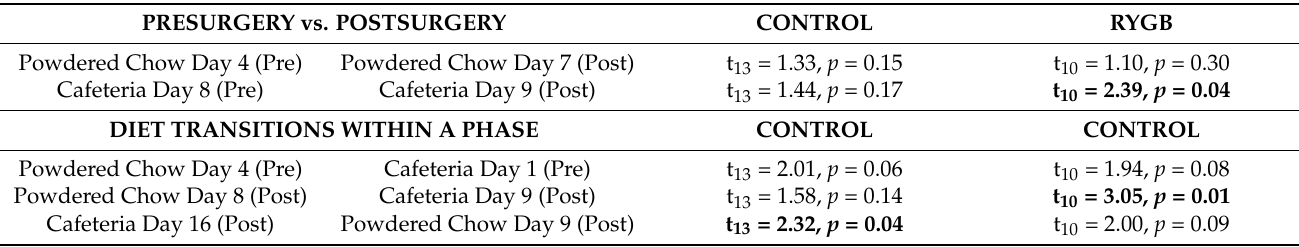
Table 9. Paired t -tests Comparing 22-H Meal Duration within Groups across Diets.